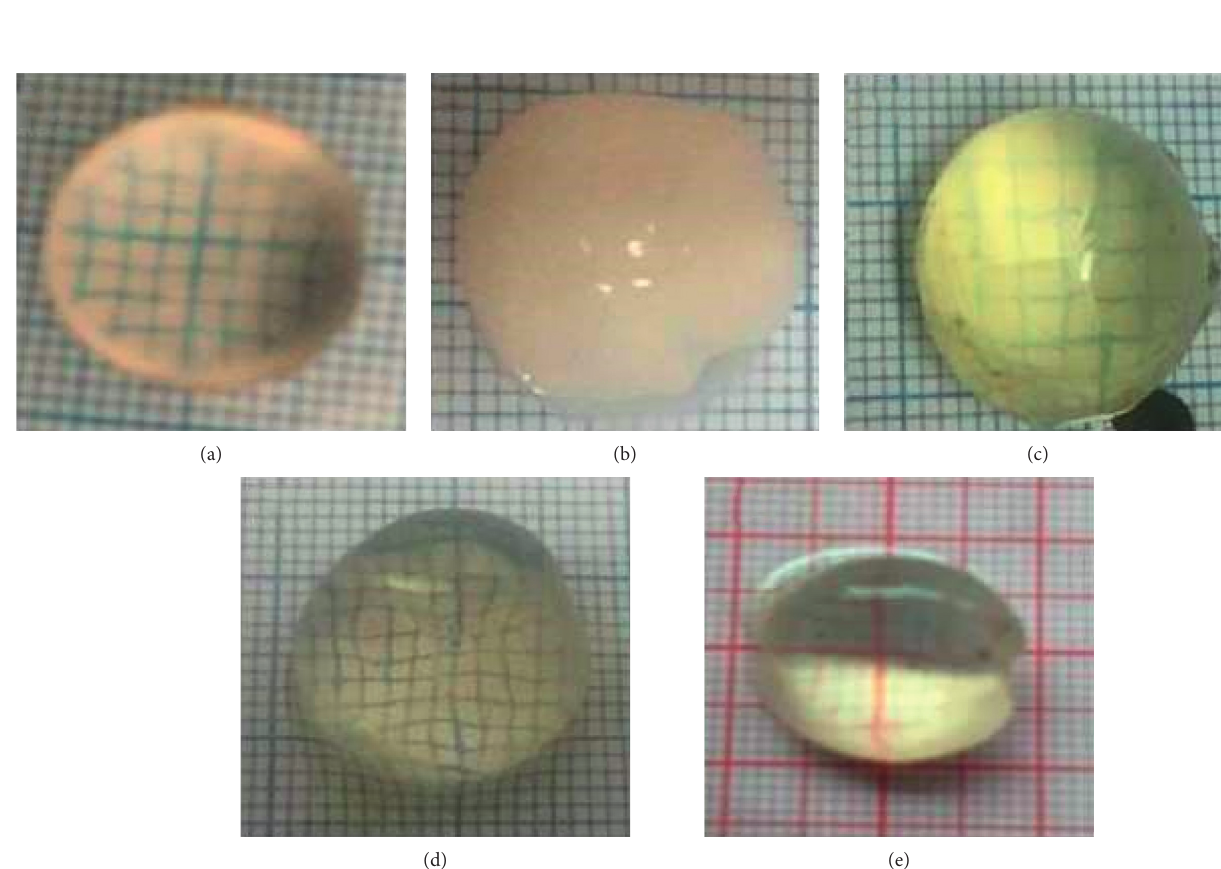
Figure 2: Comparison of lens turbidity. (a) Normal (grade 0). (b) Diabetic (grade 4). (c) Binahong 100 μ g/ml (grade 2). (d) Binahong 200 μ g/ml (grade 1). (e) Quercetin (grade 1).